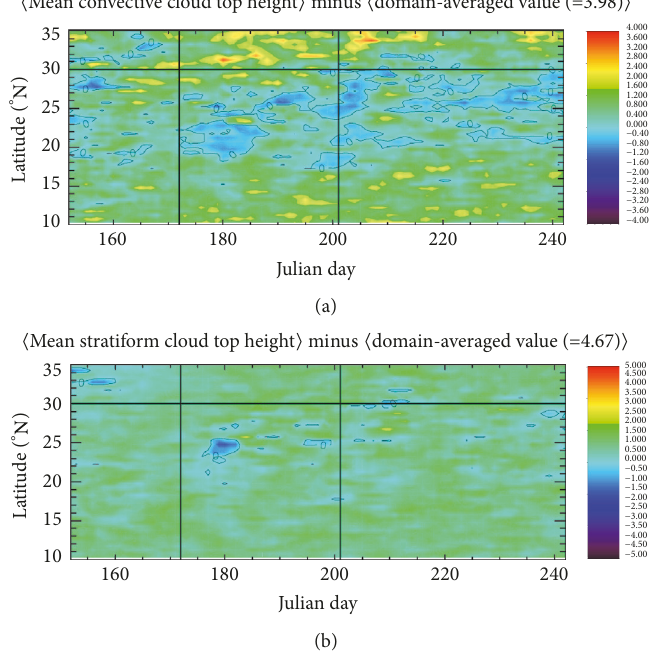
Figure 9: Climatological anomaly propagation of mean cloud top height for (a) convective and (b) stratiformrain clouds in the 2-dimensional space with time (Julian day) and latitude. The two vertical lines represent the climatological onset and retreat dates of